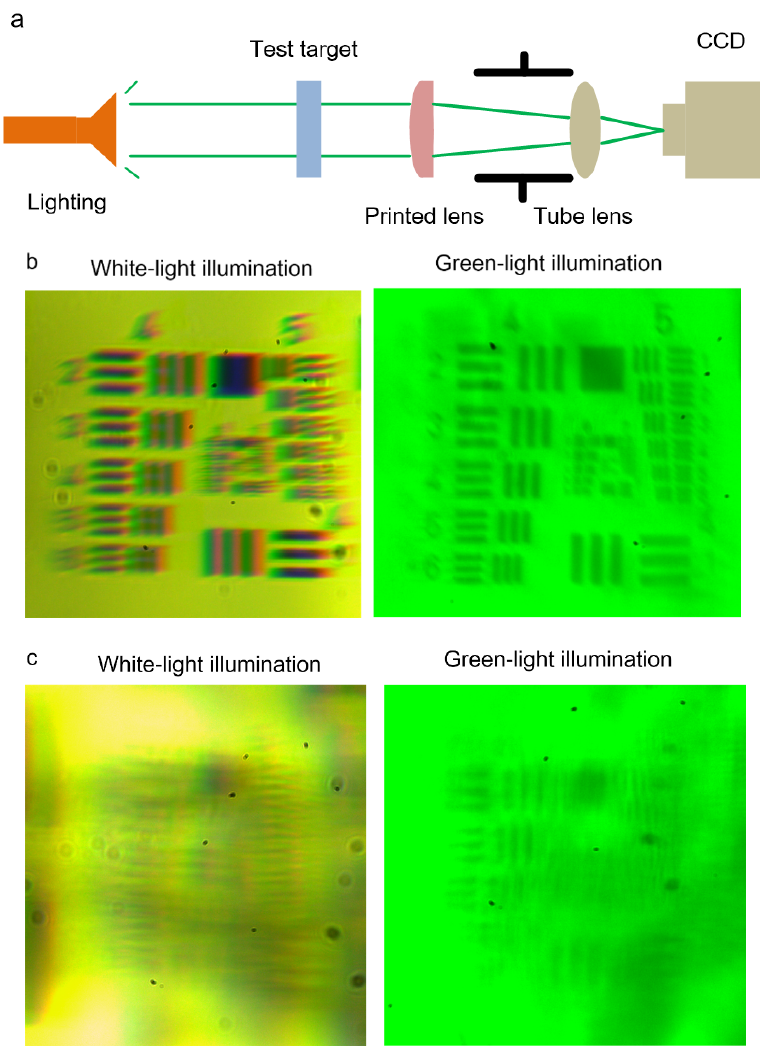
Figure 10. ( a ) Diagrammatic sketch of the experimental setup. ( b ) Recorded images of the Denta- Clear lens of the resolution target (groups 4–5) with image resolution of 28.50 lp/mm, i.e., res = 8.77 μm, under white-light illumination, 50.80 lp/mm, i.e., res = 4.92 μm, under green-light illumi- nation. ( c ) Recorded images of the HEMA lens of the resolution target (groups